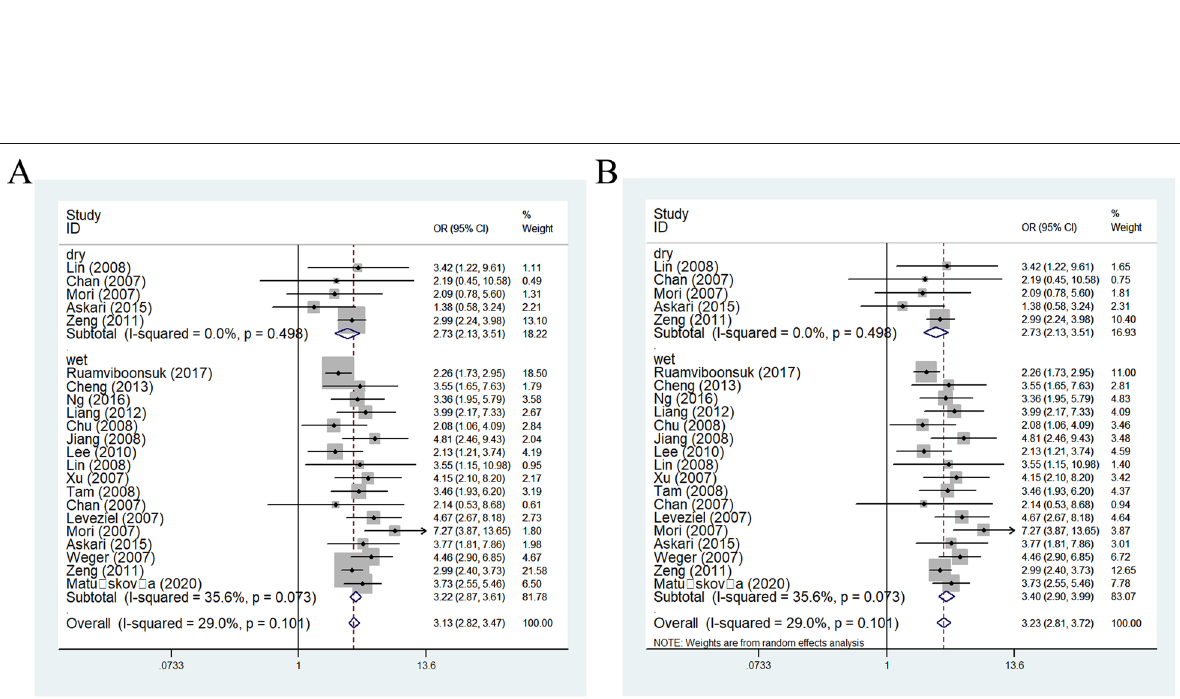
Fig. 6 Forest plot of AMD risk associated with HTRA1 gene rs11200638 polymorphism (AA+AG vs. GG) by AMD type subgroup. a : wet AMD; b : dry